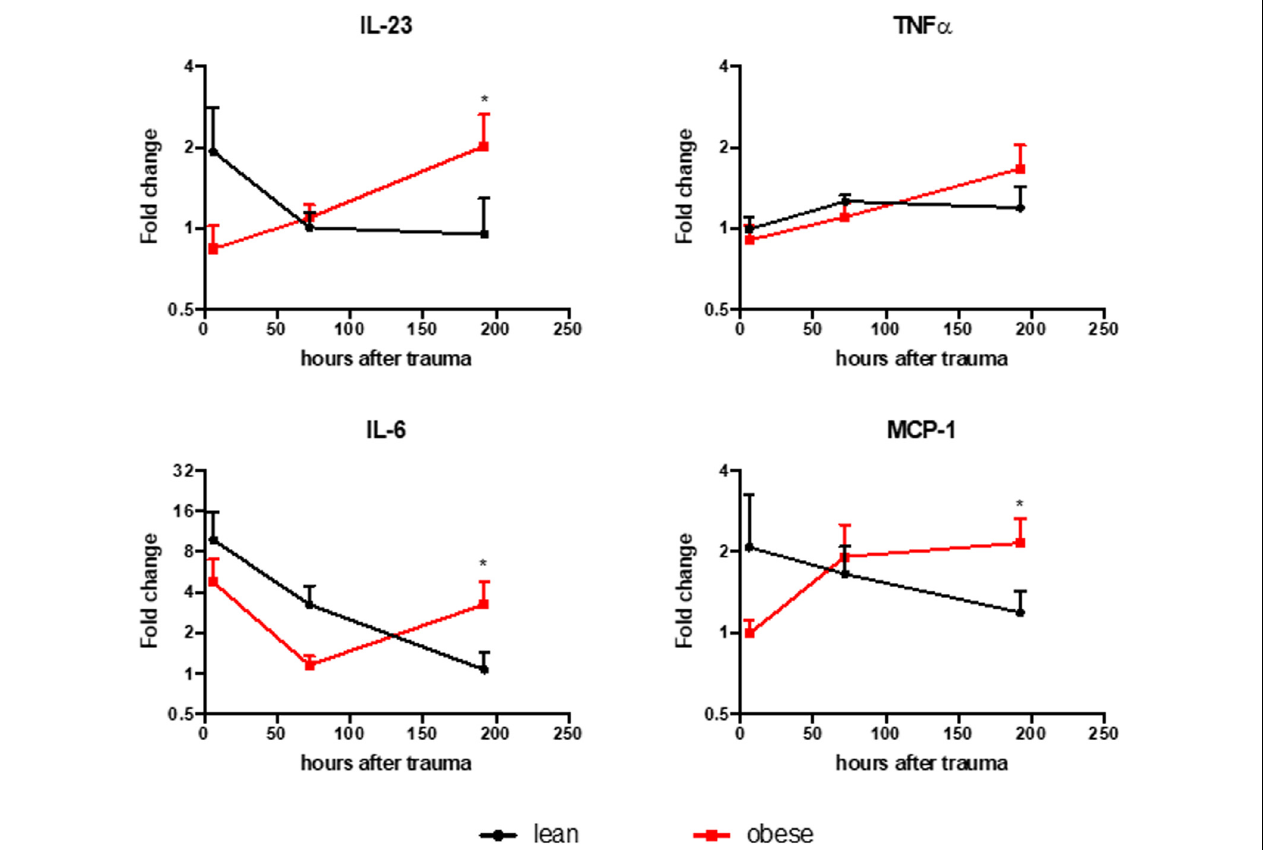
FIGURE 11 | Lean animals show resolved inflammation 192 h post trauma induction, while obese mice show elevated levels of IL-23, MCP-1, and IL-6. Legendplex assay was performed to evaluate the level of IL-23, MCP-1, IL-6, and TNFa in the plasma of lean and obese mice. The level of chemo- and cytokines were determined in control mice as well as 6, 72, and 192 h post trauma. The data is normalized to the respective control group and presented as mean ± SEM. The comparison was made between the two diets at each time point using two-way ANOVA followed by an uncorrected Fisher’s LSD test ( α = 0.05). * p < 0.05.